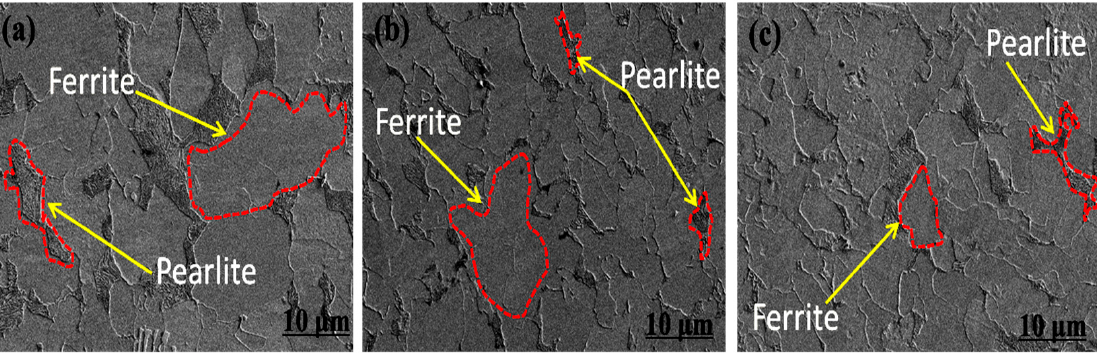
Figure 7. SEM microstructure of experimental steel with different final cooling temperature. ( a ) 650 °C; ( b ) 700 °C; ( c ) 750 °C.